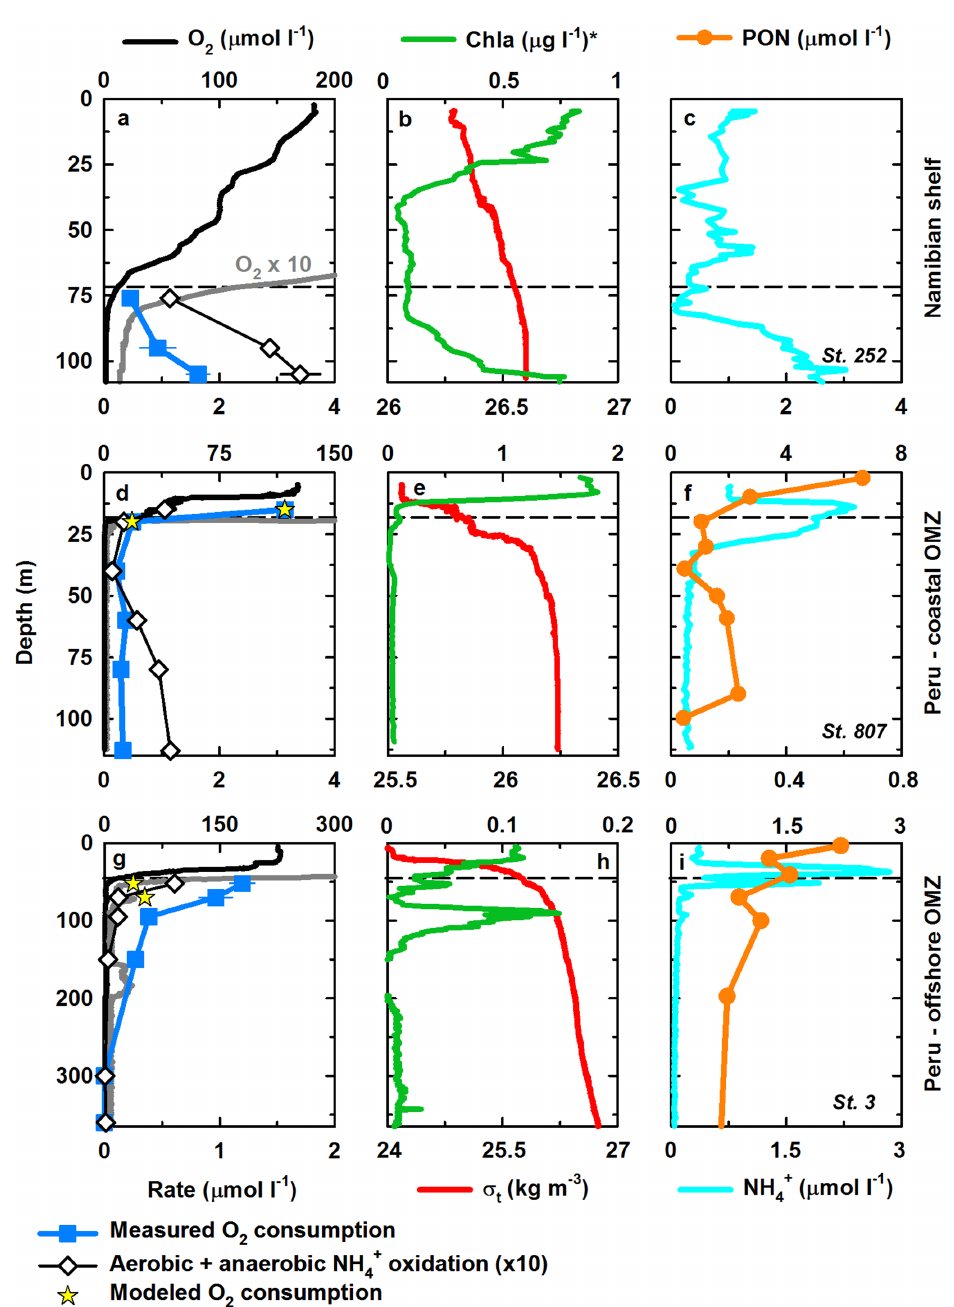
Fig 1. Physicochemical zonation and rates of microbial respiration in the OMZs off Namibia and Peru. (a-c) Namibian shelf (station 252, 111m). (d-f) Peruvian coastal OMZ (station 807, 115 m). (g-i) Offshore Peruvian OMZ (station 3, 4697 m). Dashed lines indicate the upper OMZ boundary (O 2 (cid:1) 15 μ mol l -1 ). Previously determined rates of aerobic and anaerobic NH 4+ oxidation [14,24,25] are tenfold magnified. Please note the differences in scale between stations. * Chlorophyll a concentrations in panel b in relative units.